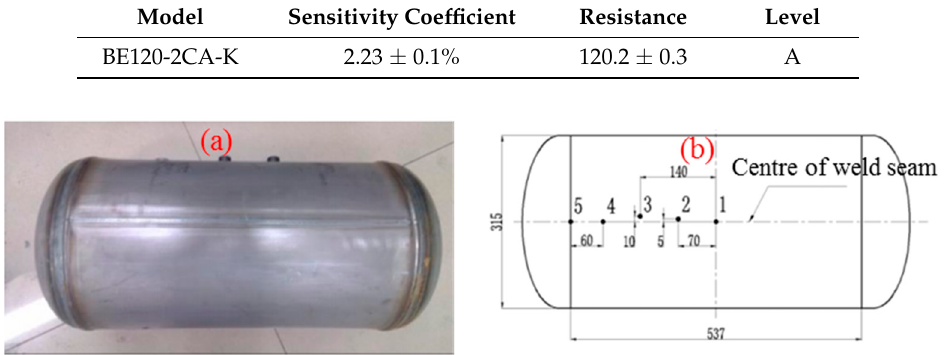
Figure 3. Physical picture ( a ) and measurement sites for the tank ( b ) under test.